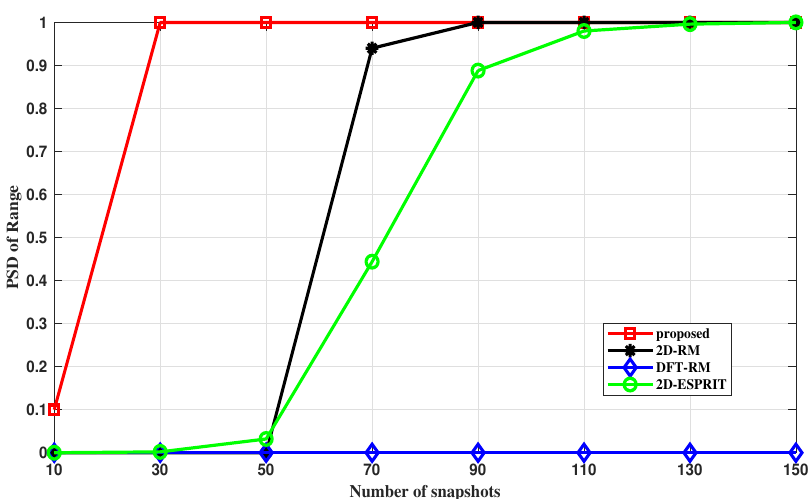
Figure 12. PSD of the DOA estimation versus the snapshots.